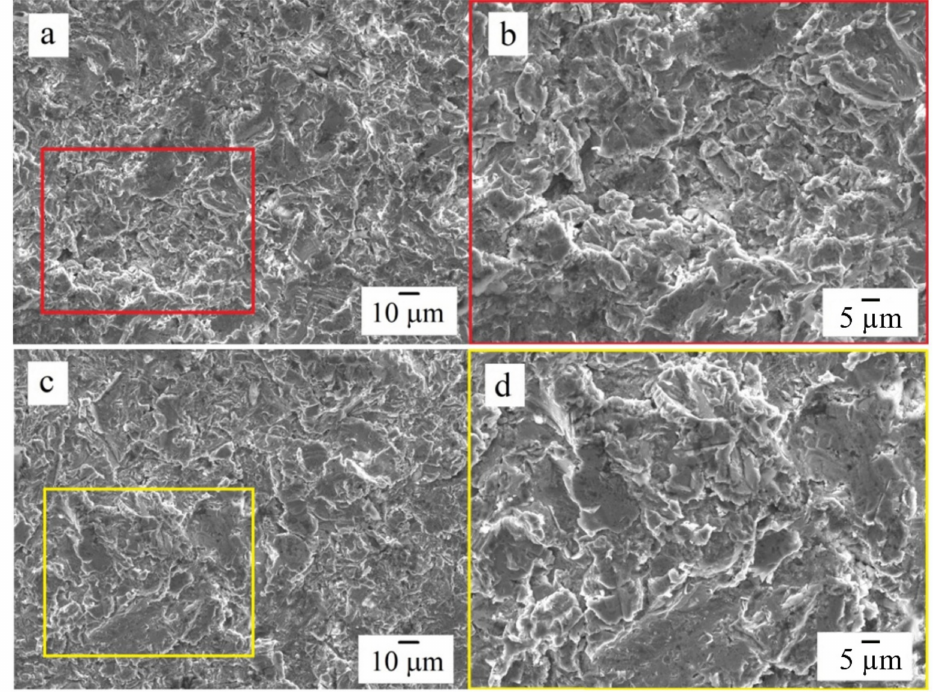
Figure 7. Surface morphology of Al 0.25 CoCrFeNiV HEA after 20 min of gas-abrasive wear for the samples without ( a , b ) and with ( c , d )